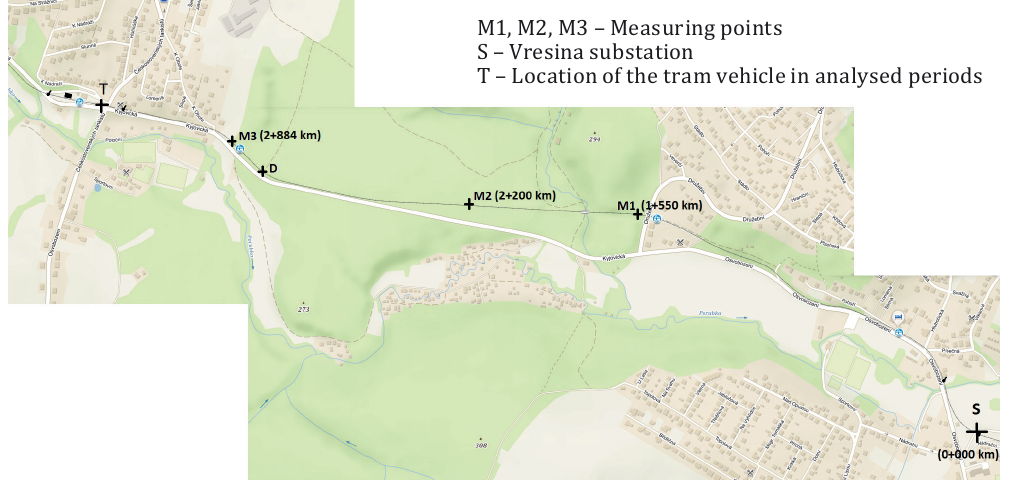
Figure 9. Measuring section at tram track infrastructure in the Ostrava, the Czech Republic